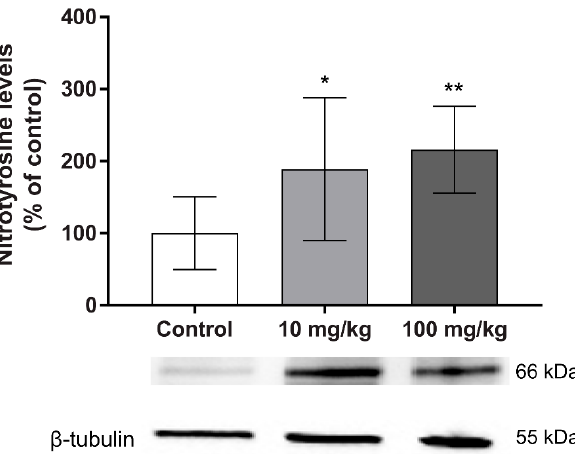
Figure 4. Persistent effects of five weeks oral DBP exposure on testicular oxidative stress in adult mice. Levels of nitrotyrosine were measured by Western blot in mouse testis collected one week after the last DBP administration. Values represent mean ± S.D. from 12 animals per group. Representative blots of three experiments are shown below the graph. β -tubulin was used as a loading control. Statistically significant differences from control are indicated as follows: ** p < 0.01 and * p < 0.05 (One-way ANOVA followed by Dunnet’s test).